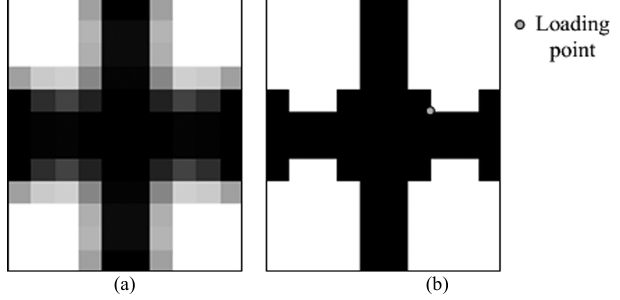
Fig. 4. Optimized topology of PCLD treatment on the rectangular plate. (a) before post-processing; (b) after post-processing. and mesh-dependency. The continuum-type optimal solution would approximate the original optimization problem with 0–1 design variables. In this work, the sensitivity filtering approach is introduced. The applied details can refer to Sigmund’s work